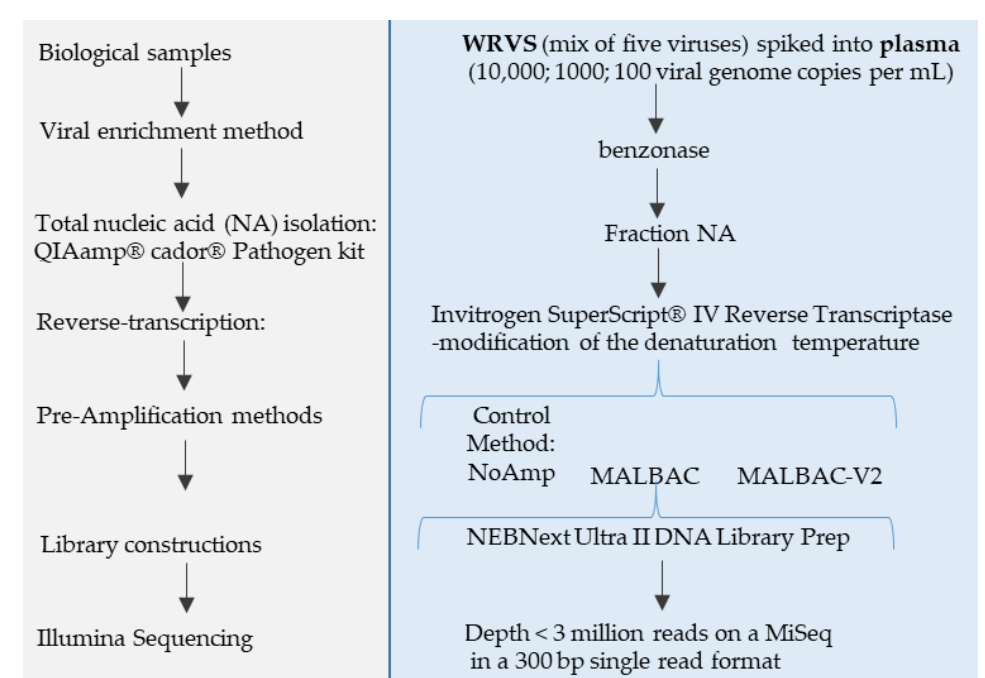
Figure 1. Experimental design with Virus Multiplex Reference Panel (VMRP). Six protocols in- cluding reverse transcription step, random pre-amplification step and subsequent library con- structions were compared to a protocol without pre-amplification (NoAmp). A first experiment was carried out directly on a mix of 26 viruses representative of the diversity of viruses (VMRP) and the second experiment on VMRP diluted in a plasma matrix (ratio: 1/10). Both fractions, total nucleic acid fraction (NA) and RNA only, were used.